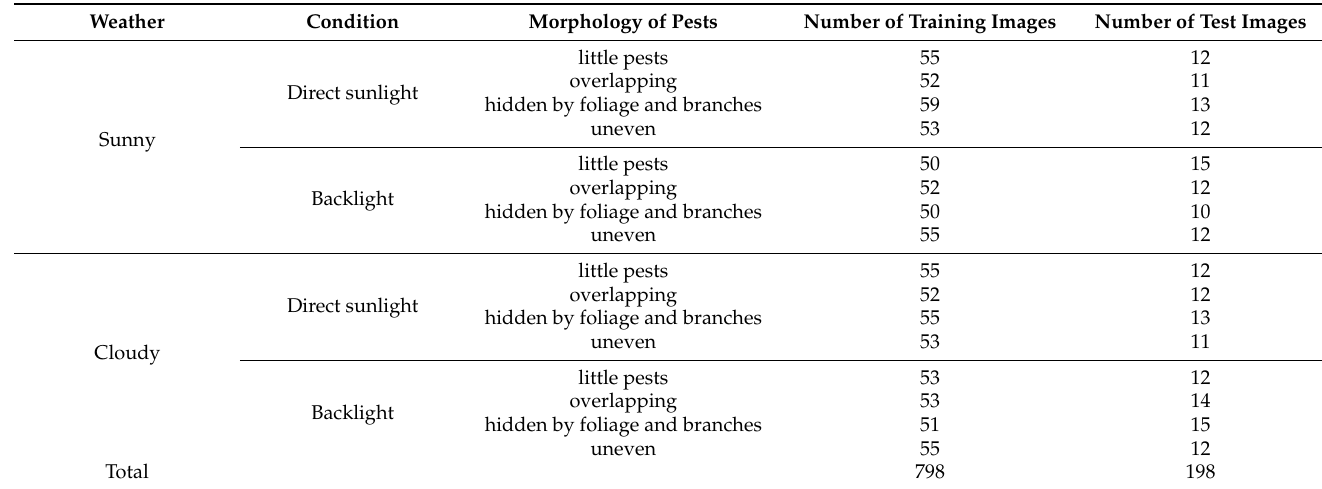
Table 1. Detailed information of training and test